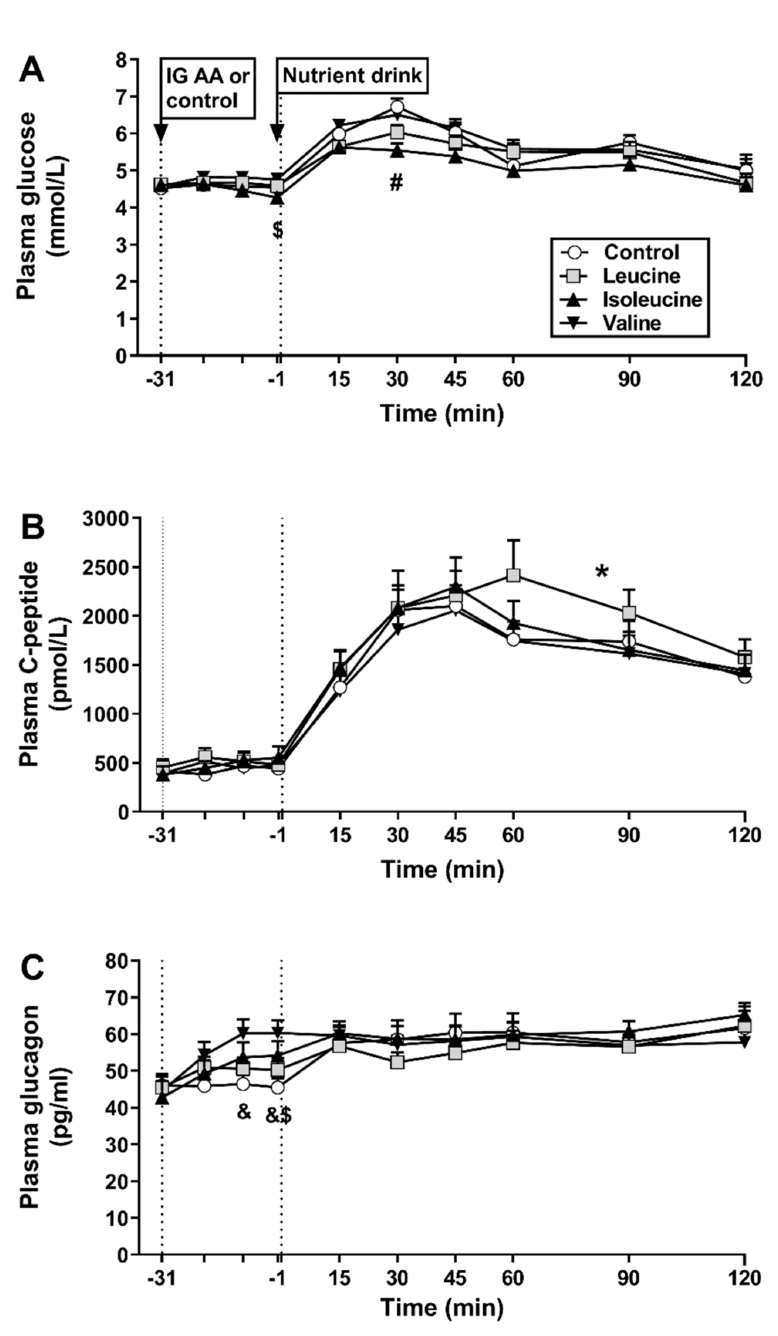
Figure 2. Plasma glucose ( A ), C-peptide ( B ) and glucagon ( C ) concentrations at baseline (t = − 31 min), in response to intragastric (IG) administration of either 10 g of leucine, 10 g of isoleucine, 10 g of valine or control (t = − 20, − 10 and − 1 min), and after a mixed-nutrient drink (t = 15–120 min). Data were analysed using repeated-measures two-way ANOVA with treatment and time as factors. Post-hoc comparisons, adjusted for multiple comparisons by Bonferroni’s correction, were conducted where ANOVAs revealed significant effects. ( A ) $ isoleucine significantly different from valine at t = − 1 min, p < 0.05; # leucine and isoleucine significantly different from both control and valine, both p < 0.05. ( B ) * leucine, but not isoleucine or valine, significantly different from control, p < 0.05. ( C ) & valine significantly different at t = − 10 and − 1 min, and $ isoleucine at t = − 1 min, from control, all p < 0.05. Data are means ± SEMs; n = 15; AA, amino